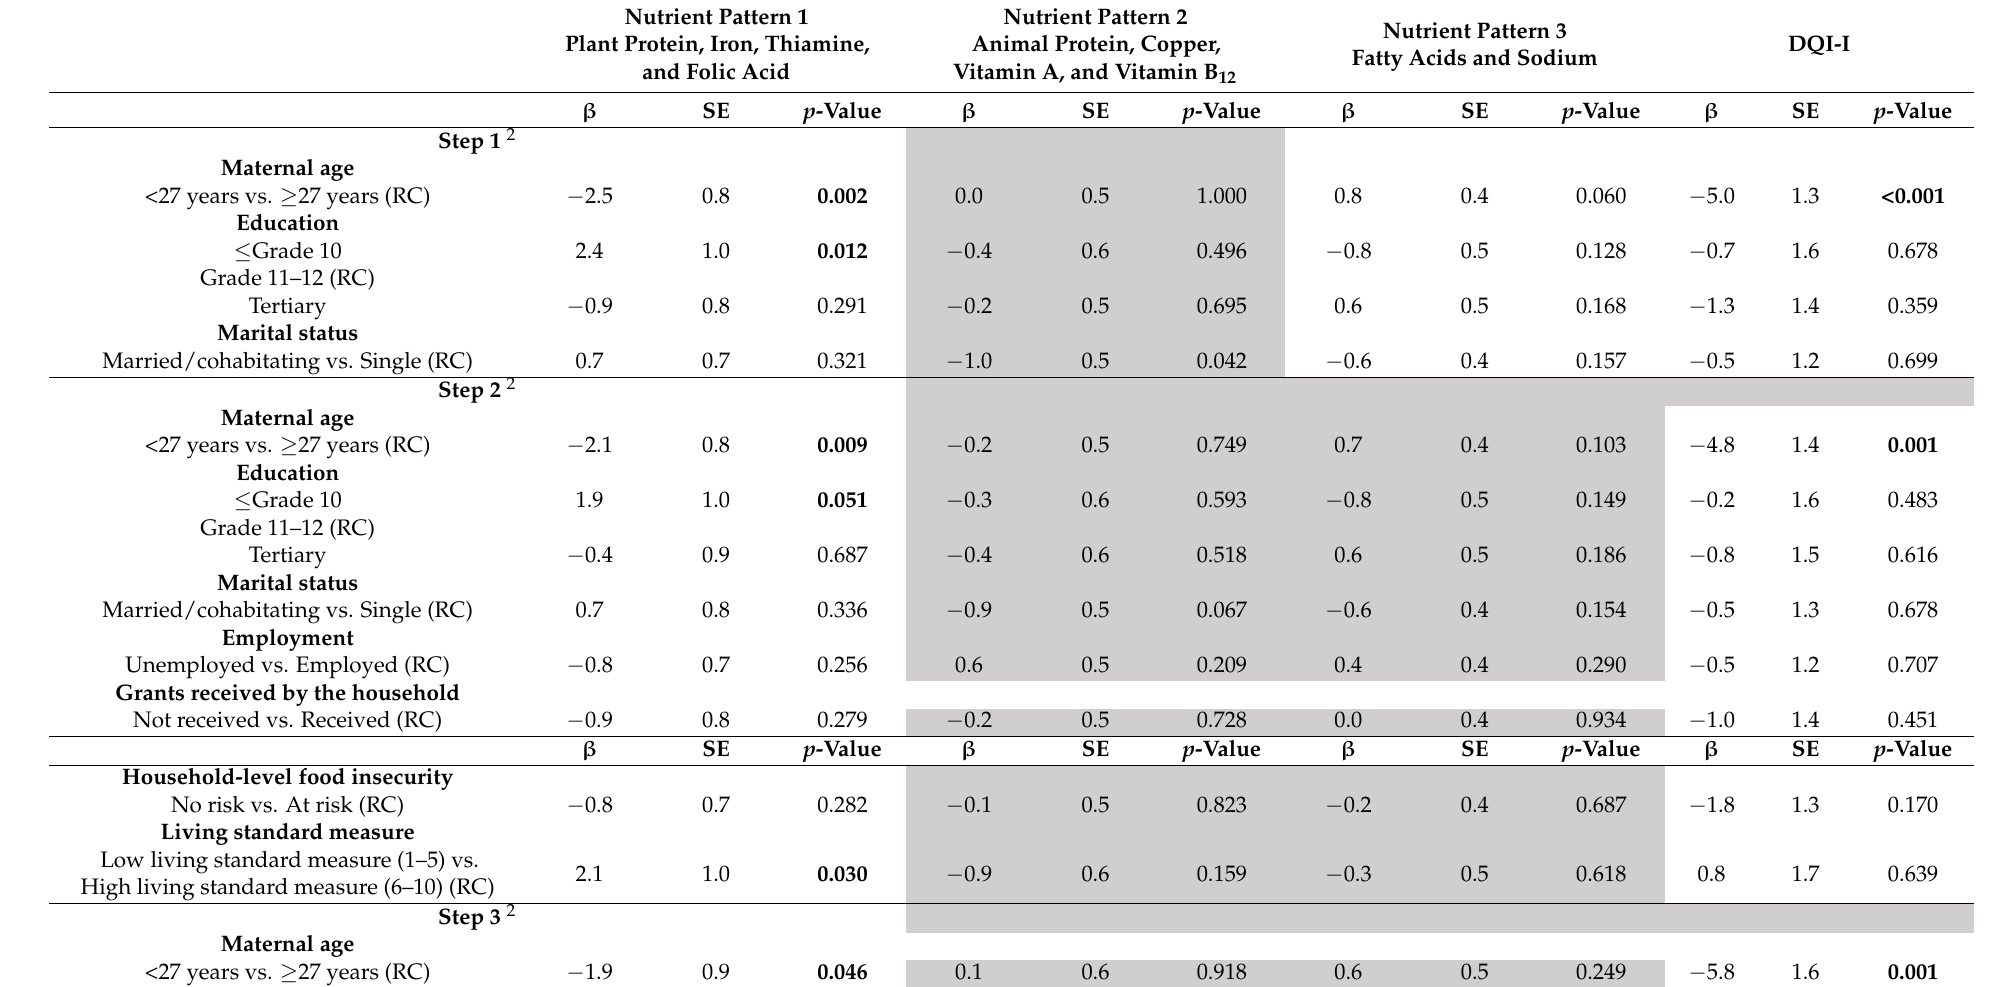
Table 6. Associations of maternal and household factors with nutrient patterns and DQI-I 1